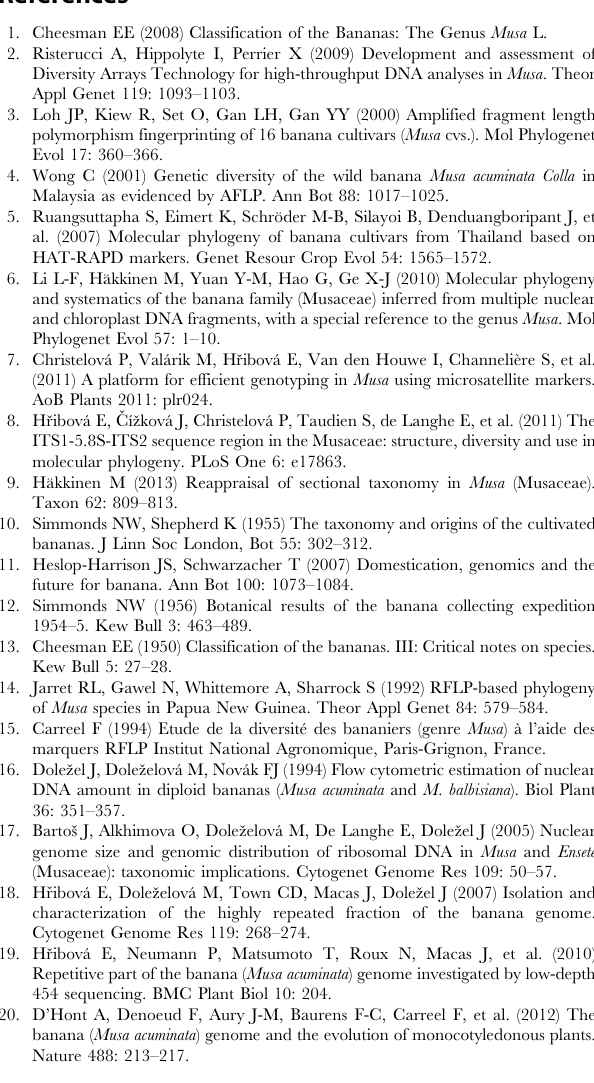
Figure S3 DH-Pahang genomic sequences together with repeat annotation were obtained from the Banana Genome Hub (http://banana-genome.cirad.fr/) and analyzed using the Profrep tool against our Musaceae sequence database. (A) Six tracks show the number of similarity hits against reads from six Musaceae genomes as calculated by Profrep. (B) Annotation of genomic region based on our M. acuminata repeat annotation and Profrep analysis. (C) Annotation of repeats in the DH-Pahang genome obtained from the Banana Genome Hub. Figure S4 Comparison of repetitive content in shotgun sequencing data and genome assemblies of M. acumi- nata and M. balbisiana . Each dot represents a sequence read. The X and Y axes show the normalized number of similarity hits detected in shogun data and assembly, respectively. (PNG) File S1 DNA alignment of reverse transcriptase se- quences derived from the Ty3/gypsy CRM element from cluster